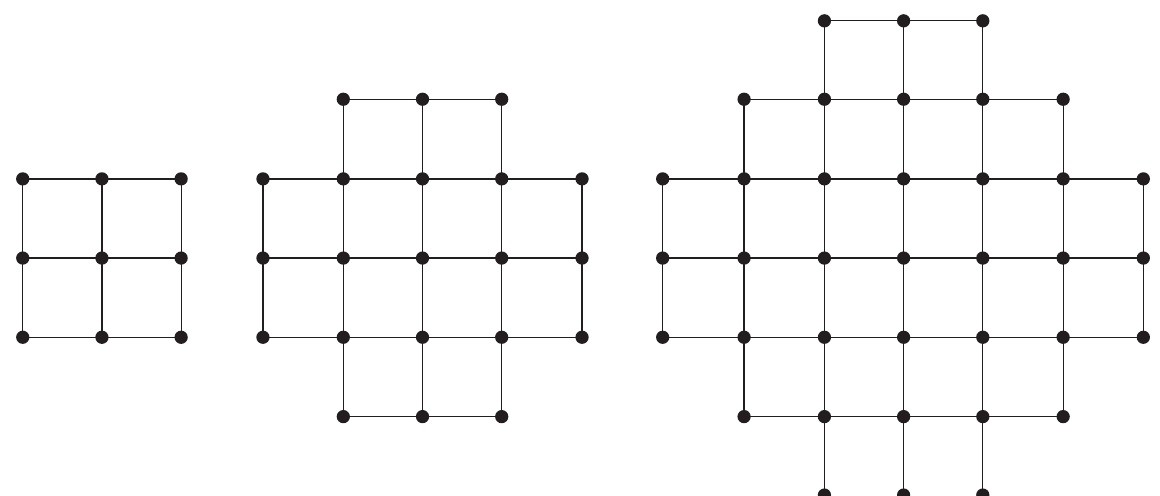
Figure 3: Structure of Aztec diamond networks AZN ( 1 ) , AZN ( 2 ) , and AZN ( 3 ) (from left to right),